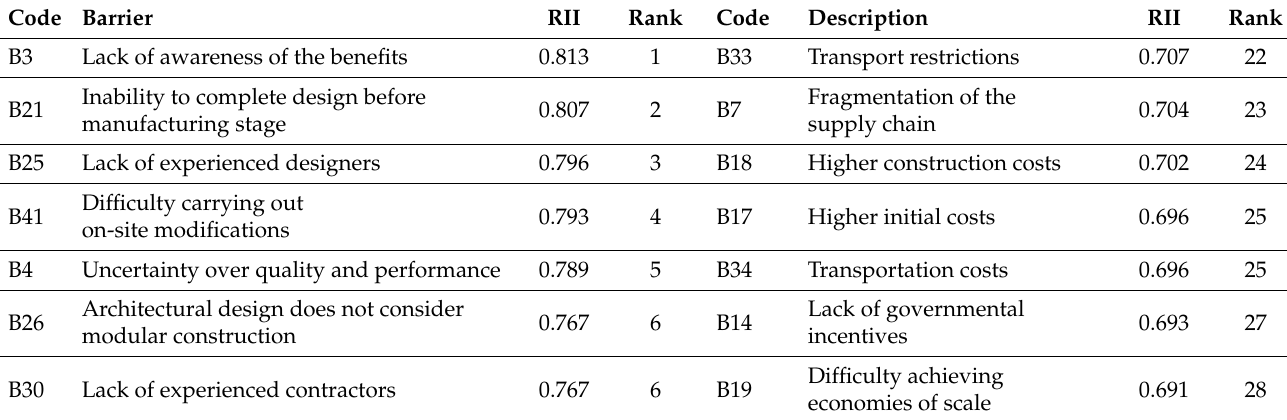
Table A1. Overall ranking of the barriers to the